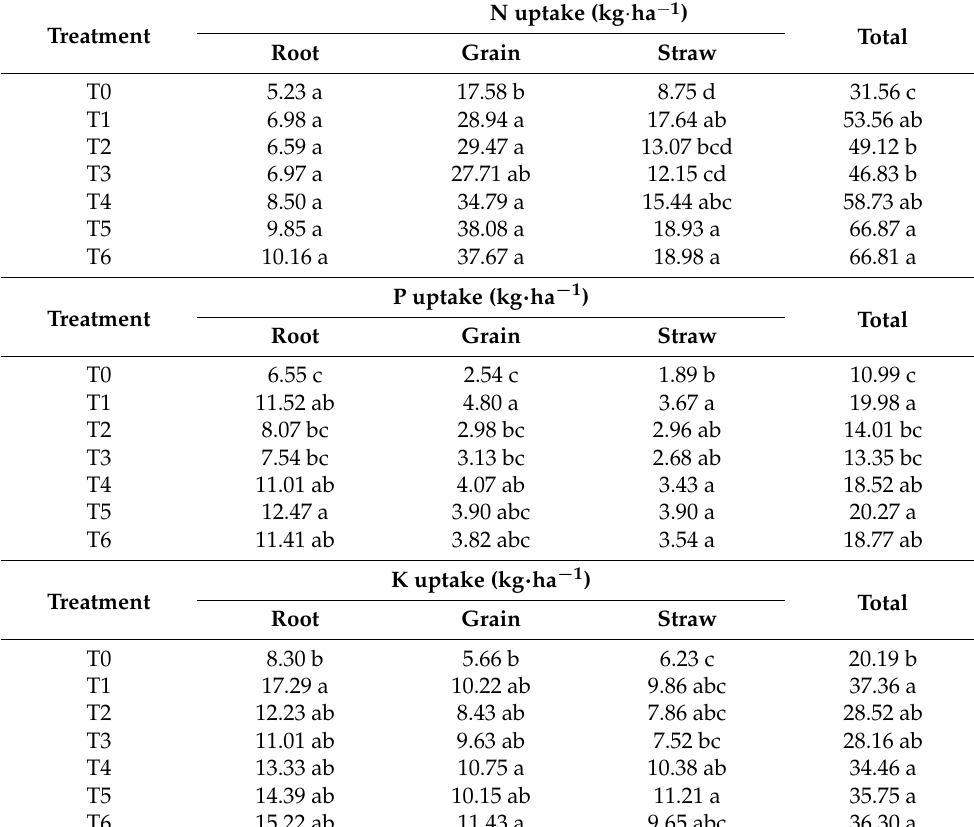
Table 6. Effect of fertilizer on N, P and K uptake (kg · ha − 1 ) in rice plants.